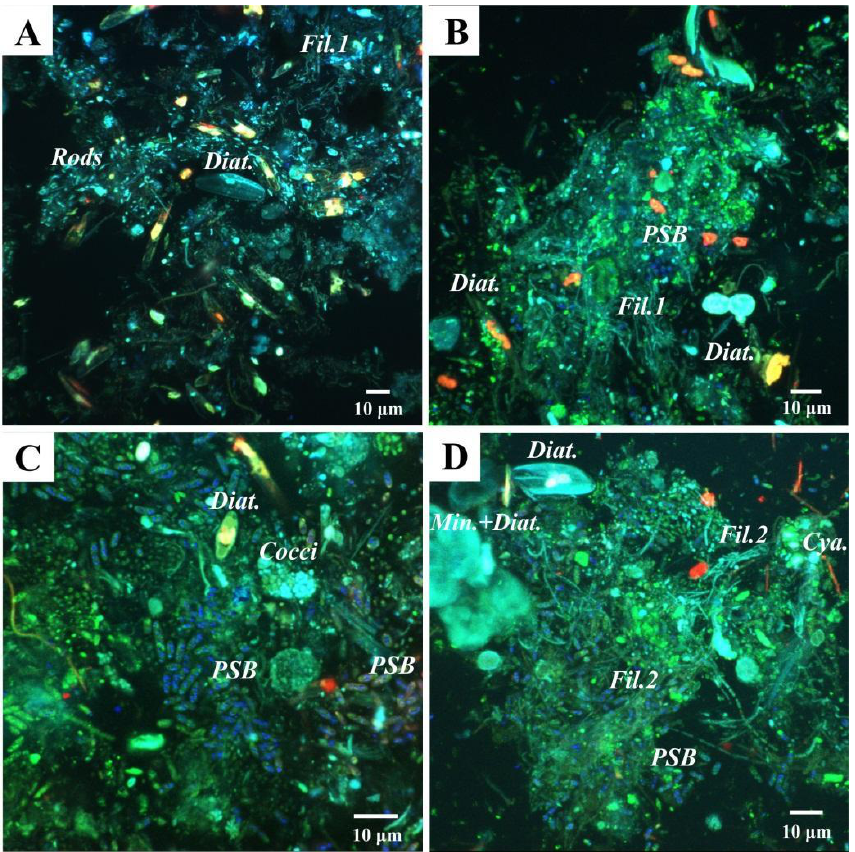
Figure 9. Confocal Laser Scanning Microscopy (CLSM) images of the studied microbial mat layers. ( A , B ) Top layer of the mat, where ( A ) shows a fixed sample without staining and ( B ) shows a sample stained with Syto ® 9 (DNA staining). Diatoms are visible in light blue (Diat.), and also rod-shaped bacteria (Rods) and filamentous bacteria (Fil.1). Purple Sulfur Bacteria (PSB) are detected due to laser reflection of the sulfur globules inside the cells in dark blue; ( C , D ) CLSM images that correspond to Layers 2 and 3, both stained with Syto ® 9; ( C ) Abundant PSB are visualized, as well as dense colonies of autoflourescent cocci (Cocci), and some diatoms (Diat.); ( D ) Filamentous bacteria, possibly Chloroflexi (Fil.2), diatoms (Diat.), and diatoms frustules associated with globules of minerals (Min. + Diat.) detected in light blue, PSB in dark blue, and a few Cyanobacteria (Cya.) in red, due to chlorophyll a fluorescence.